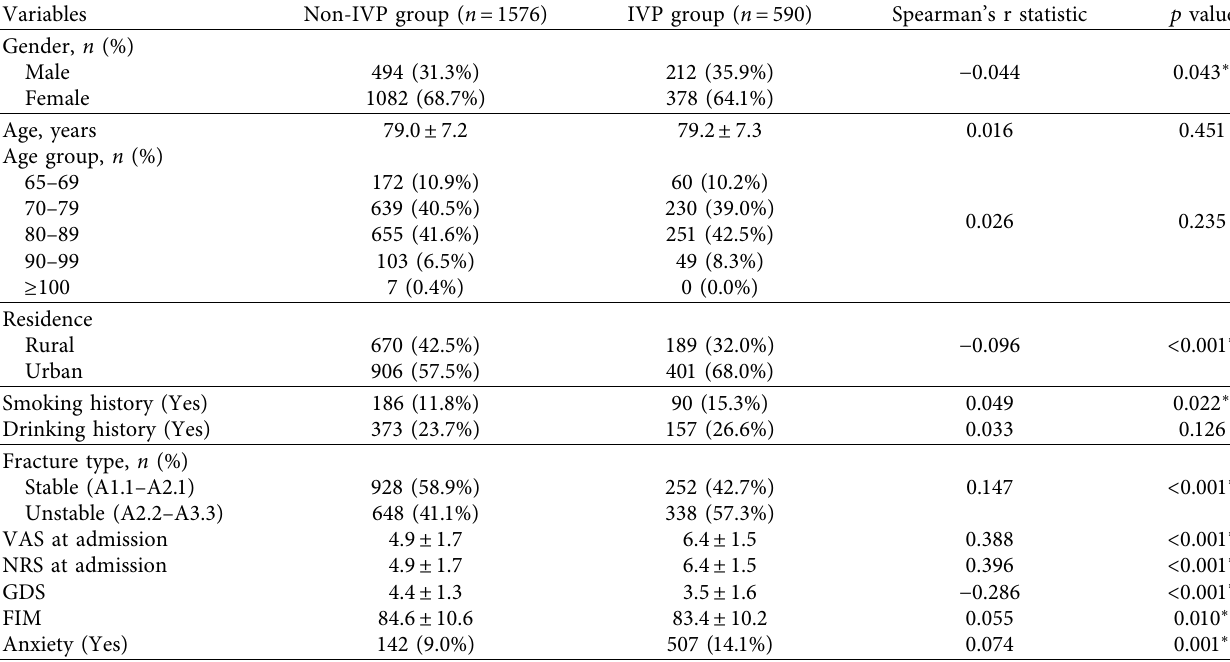
Table 3: The association of IVP group with gender, age, residence, smoking or drinking history, fracture type, pain scores at admission, GDS, FIM, and